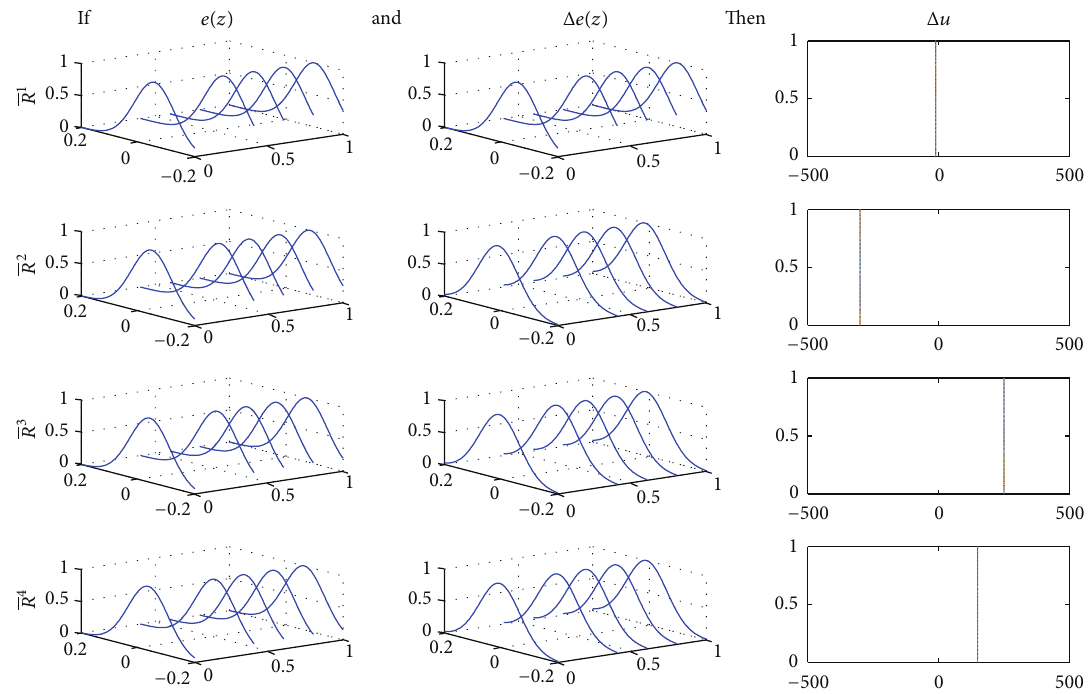
Figure 8: The first four 3D fuzzy rules and their associated MFs ( 𝑏 = −0.0752